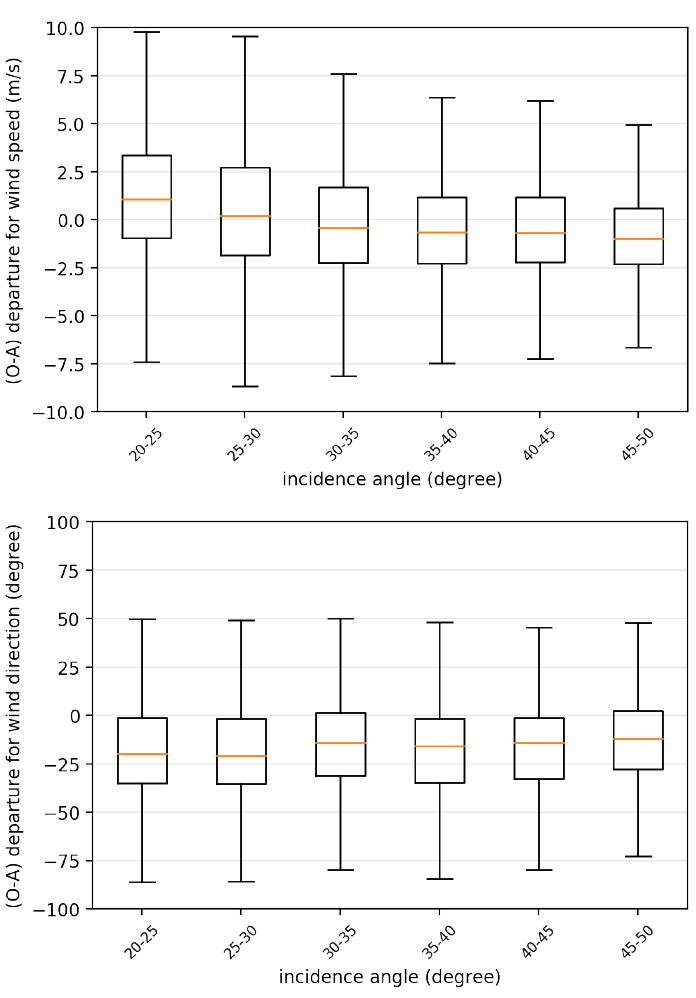
Figure 4. (O-A) for wind speed with respect to the SAR angle of incidence ( top ). (O-A) for wind direction with respect to the SAR angle of incidence ( bottom ). The SAR data are binned in 5° intervals for incidence angle between 20° and 50°. Each box extends from the lower (Q1) to upper quartile (Q3) values of the data, with a red line at the median. The whiskers represent the 1.5 interquantile range